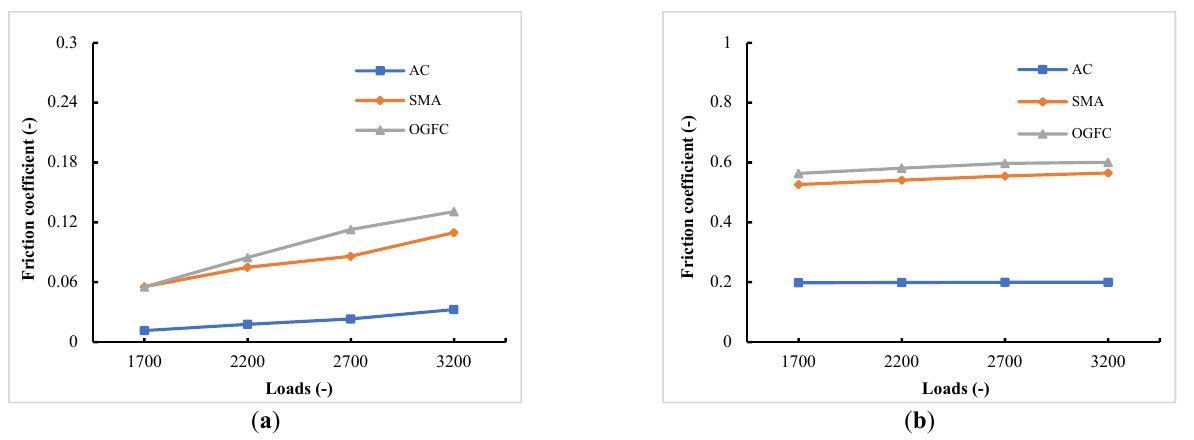
Figure 10. Variation laws of friction coefficient with tire pressure. ( a ) Tire free rolling state; ( b ) tire braking state.